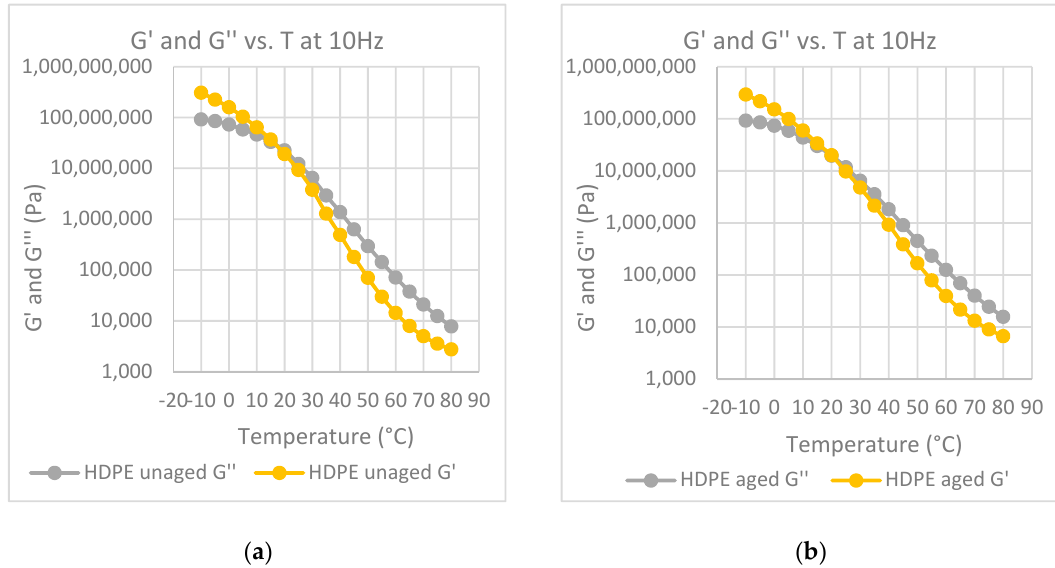
Figure 8. Elastic modulus, G,’ and loss modulus, G ′′ , at 10 Hz, as a function of temperature: ( a ) binder modified with HDPE before aging; ( b ) binder modified with HDPE after aging at the RTFOT.